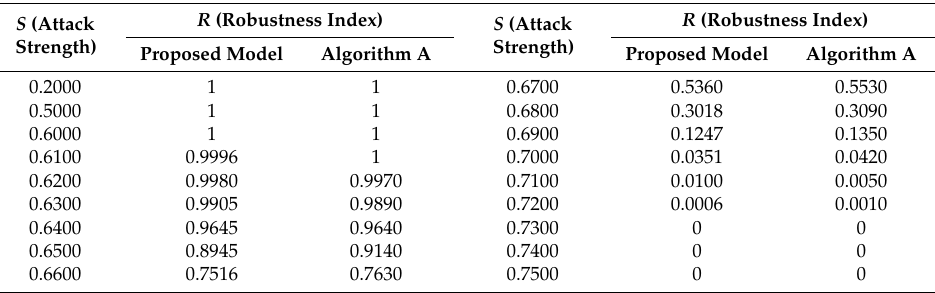
Table 2. Part of robustness results in Experiment 1.